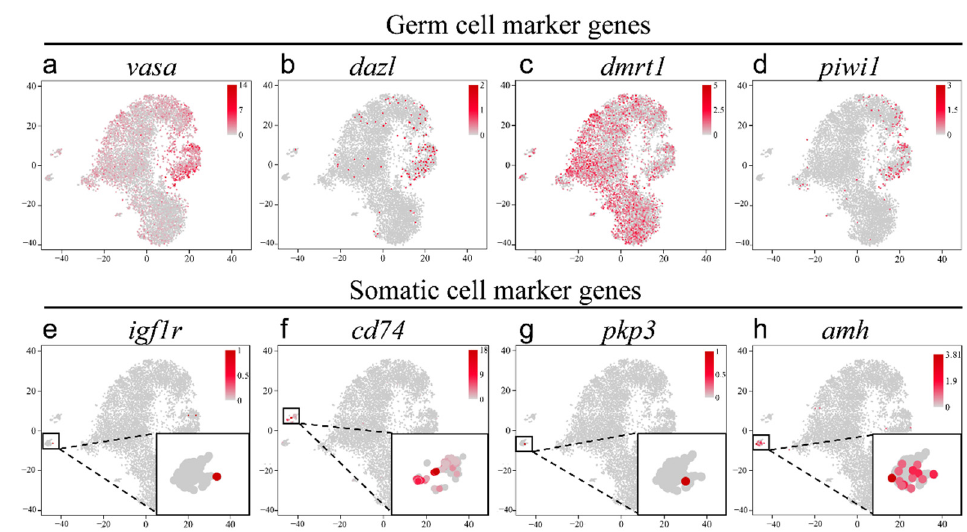
Figure 3. The known markers located in all clusters visualized by t-SNE. ( a – d ) The germ cell marker genes. ( a ) vasa , ( b ) dazl , ( c ) dmrt1 , ( d ) piwi1 . ( e – h ) The somatic cell marker genes. ( e ) igf1r , ( f ) cd74 , ( g ) pkp3 , ( h ) amh .